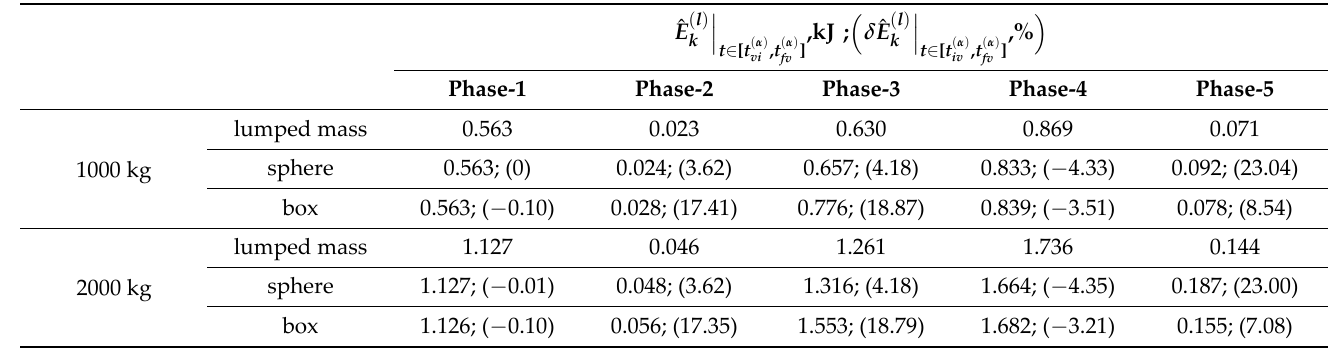
Table 4. The kinetic energy arithmetic average deviation from the integral mean values in the move‑ ment phases and their relative percentage